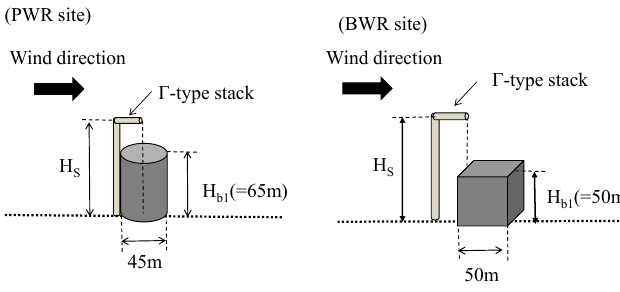
Figure 1. Schematic view of the pressurized-water reactor (PWR) and boiling-water reactor (BWR) sites.